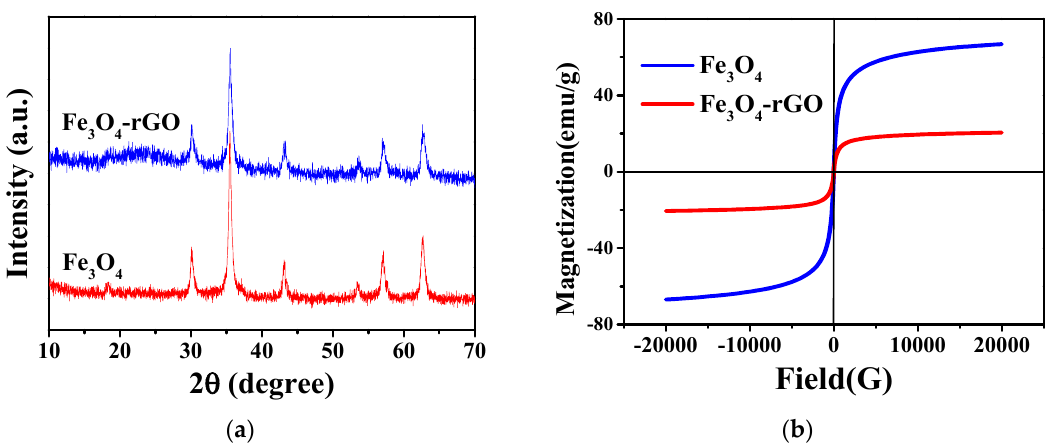
Figure 2. ( a ) XRD patterns and ( b ) magnetic hysteresis loops of Fe 3 O 4 and Fe 3 O 4 -rGO. Electrochemical impedance spectroscopy (EIS) measurement was carried out in 0.1 mol/L KCl solution containing 5 mM K 3 [Fe(CN) 6 ] and 5 mM K 4 [Fe(CN) 6 ] with an ampli-